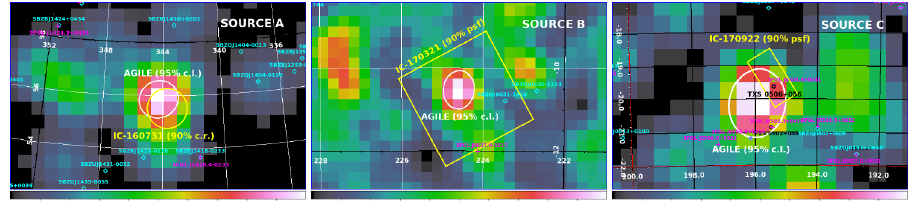
Figure 1. AGILE intensity maps above 100 MeV, in (ph cm − 2 s − 1 sr − 1 ) and galactic coordinates, centered at the position of the IceCube events IC-160731 ( left panel ), IC-170321 ( middle panel ), and IC-170922 ( right panel ), for the three AGILE detections A, B and C near the IceCube T 0 ’s. The AGILE 95% confidence level location contours, obtained with the maximum likelihood AGILE analysis [17], are shown in white; the IceCube position uncertainty boxes / circles in yellow. The positions of the classified AGNs from the BZCAT Catalog [22] and the 3FGL γ -ray sources [23] are shown in cyan and magenta colors,